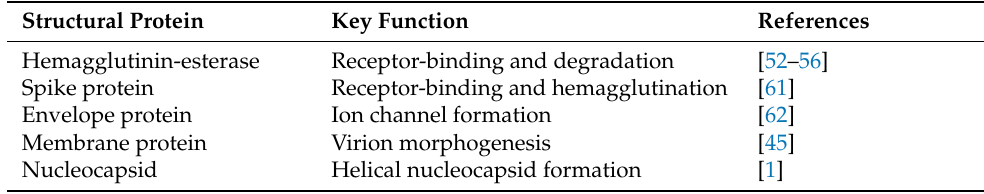
Table 1. Major characteristics of structural proteins of